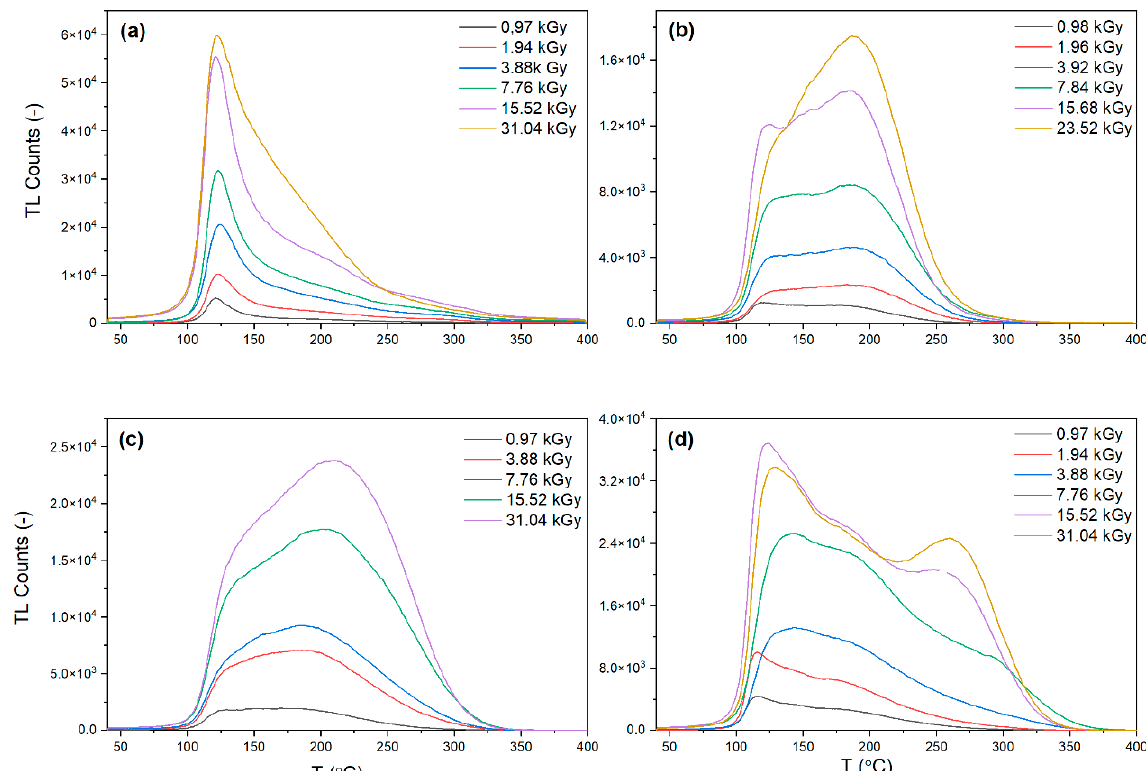
Figure 2. TL curves for samples irradiated using beta radiation (4 μ s pulse duration), PPG ( a ), PPG_Tb01 ( b ), PPG_Tb05, ( c ) and PPG_Tb30 ( d ). PPG samples were read without shutter.